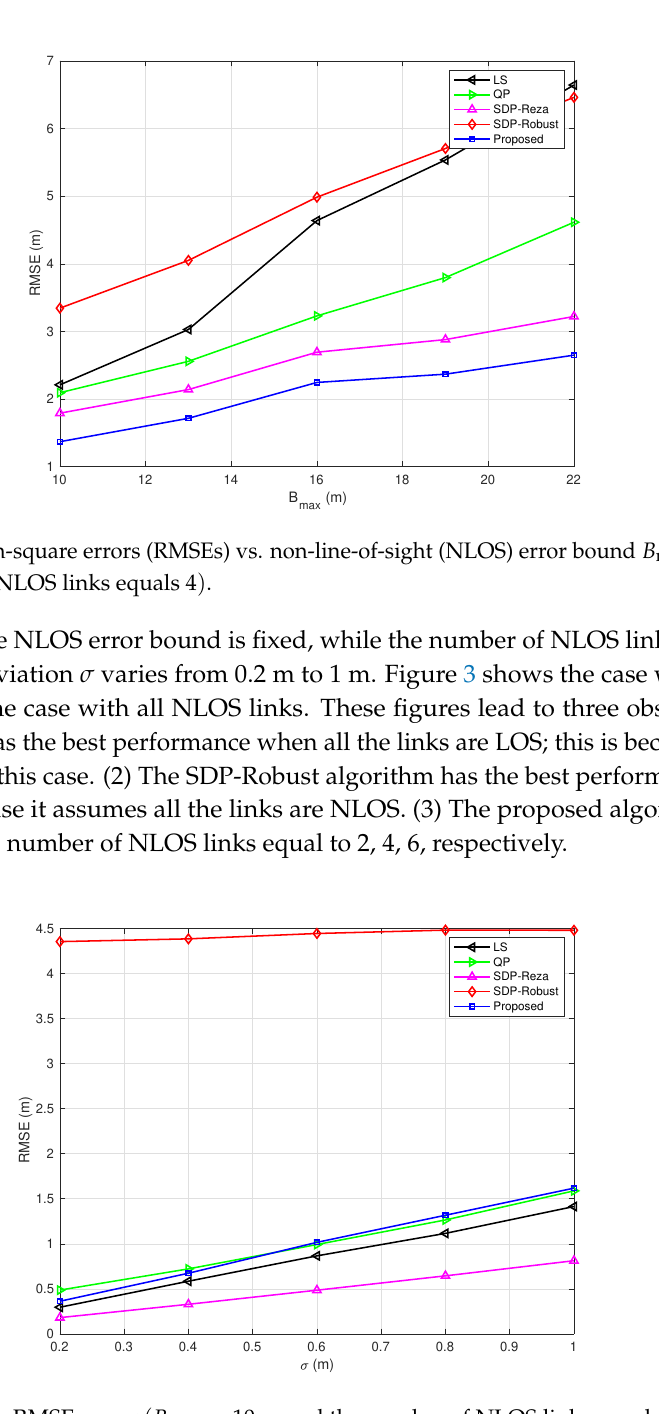
Figure 3. RMSEs vs. σ ( B max = 10 m and the number of NLOS links equals 0 )